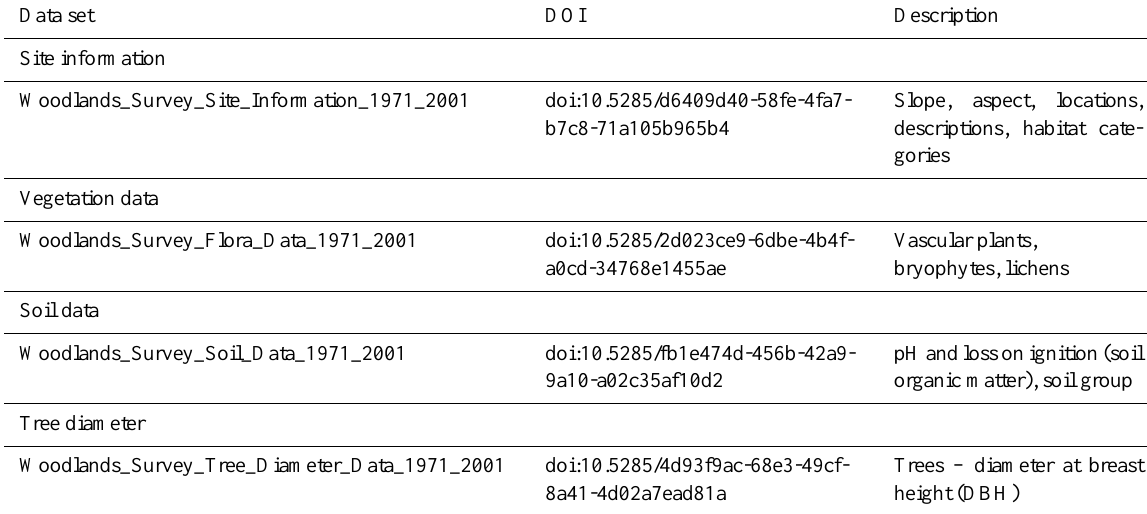
Table 5. Summary of data sets available. Data set